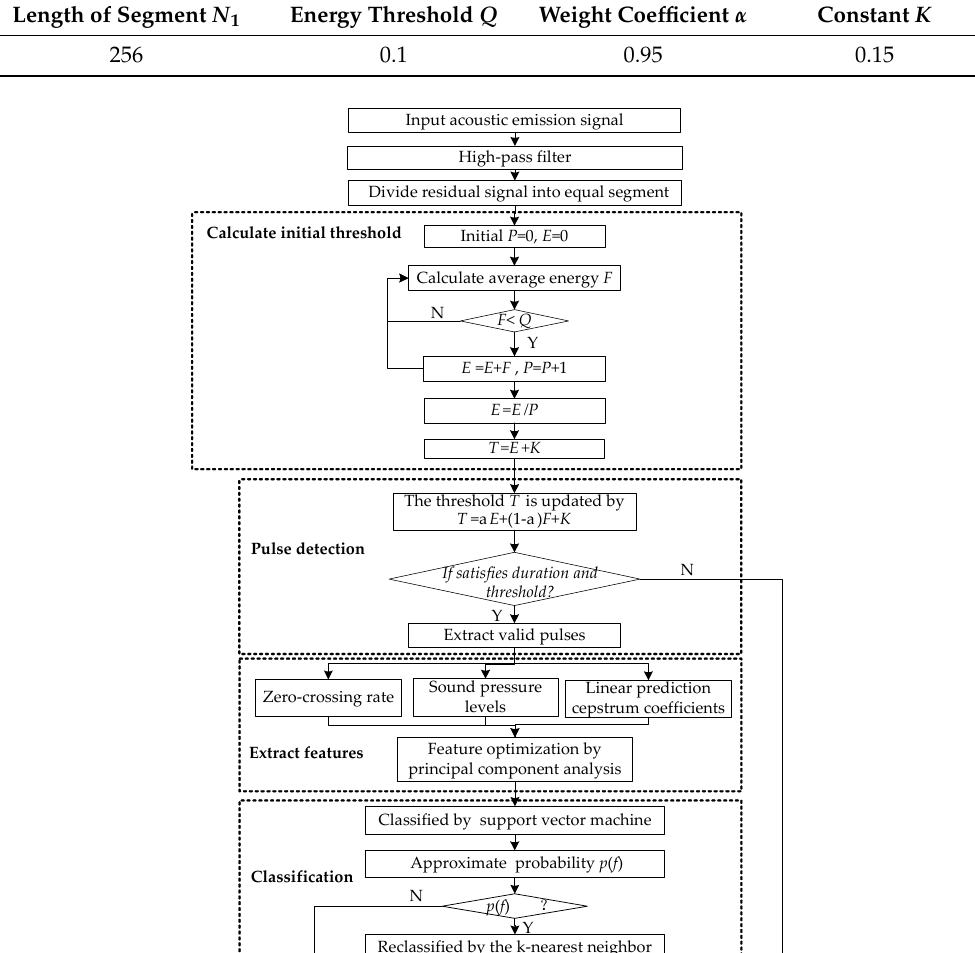
Table 1. Parameters of the sound pulse detection.